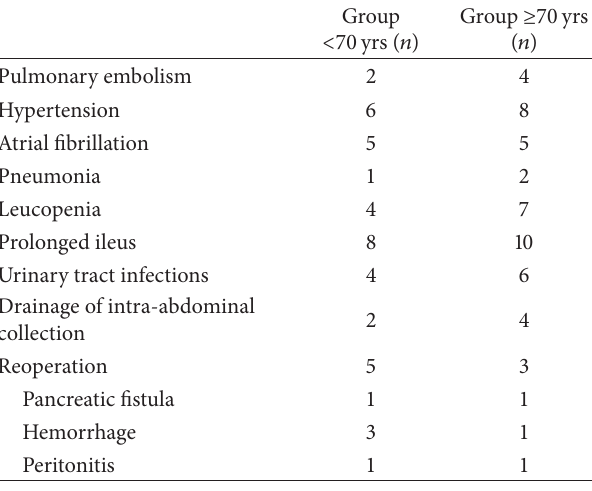
Table 4: Complications in both groups.